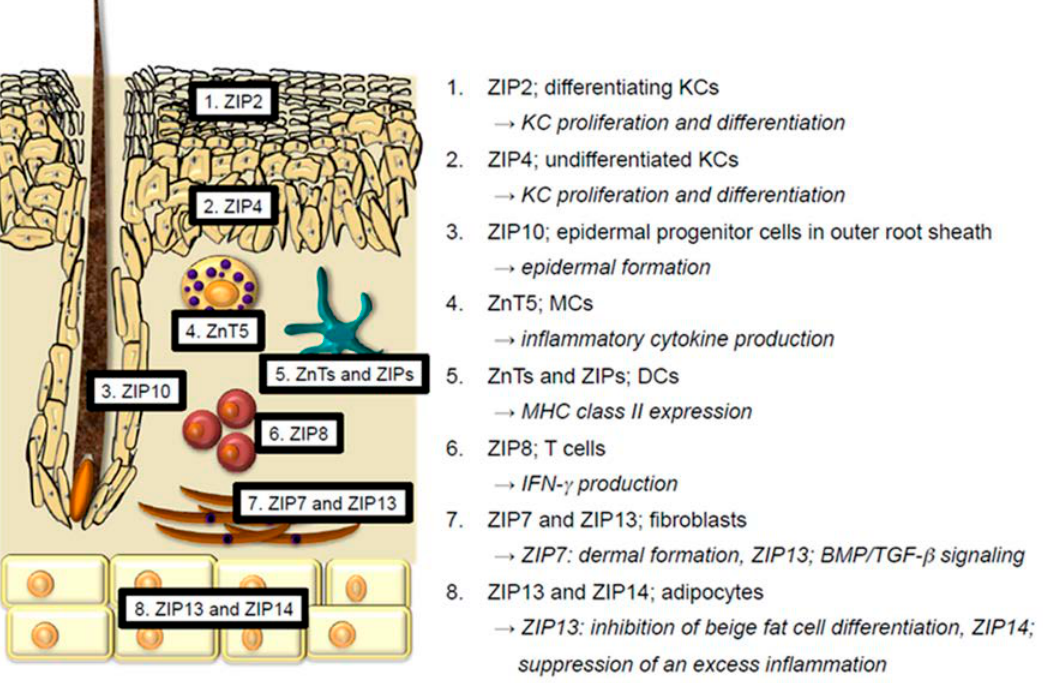
morphogenetic protein/transforming growth factor- β (BMP/TGF- β ) signaling, respectively. 8. ZIP13